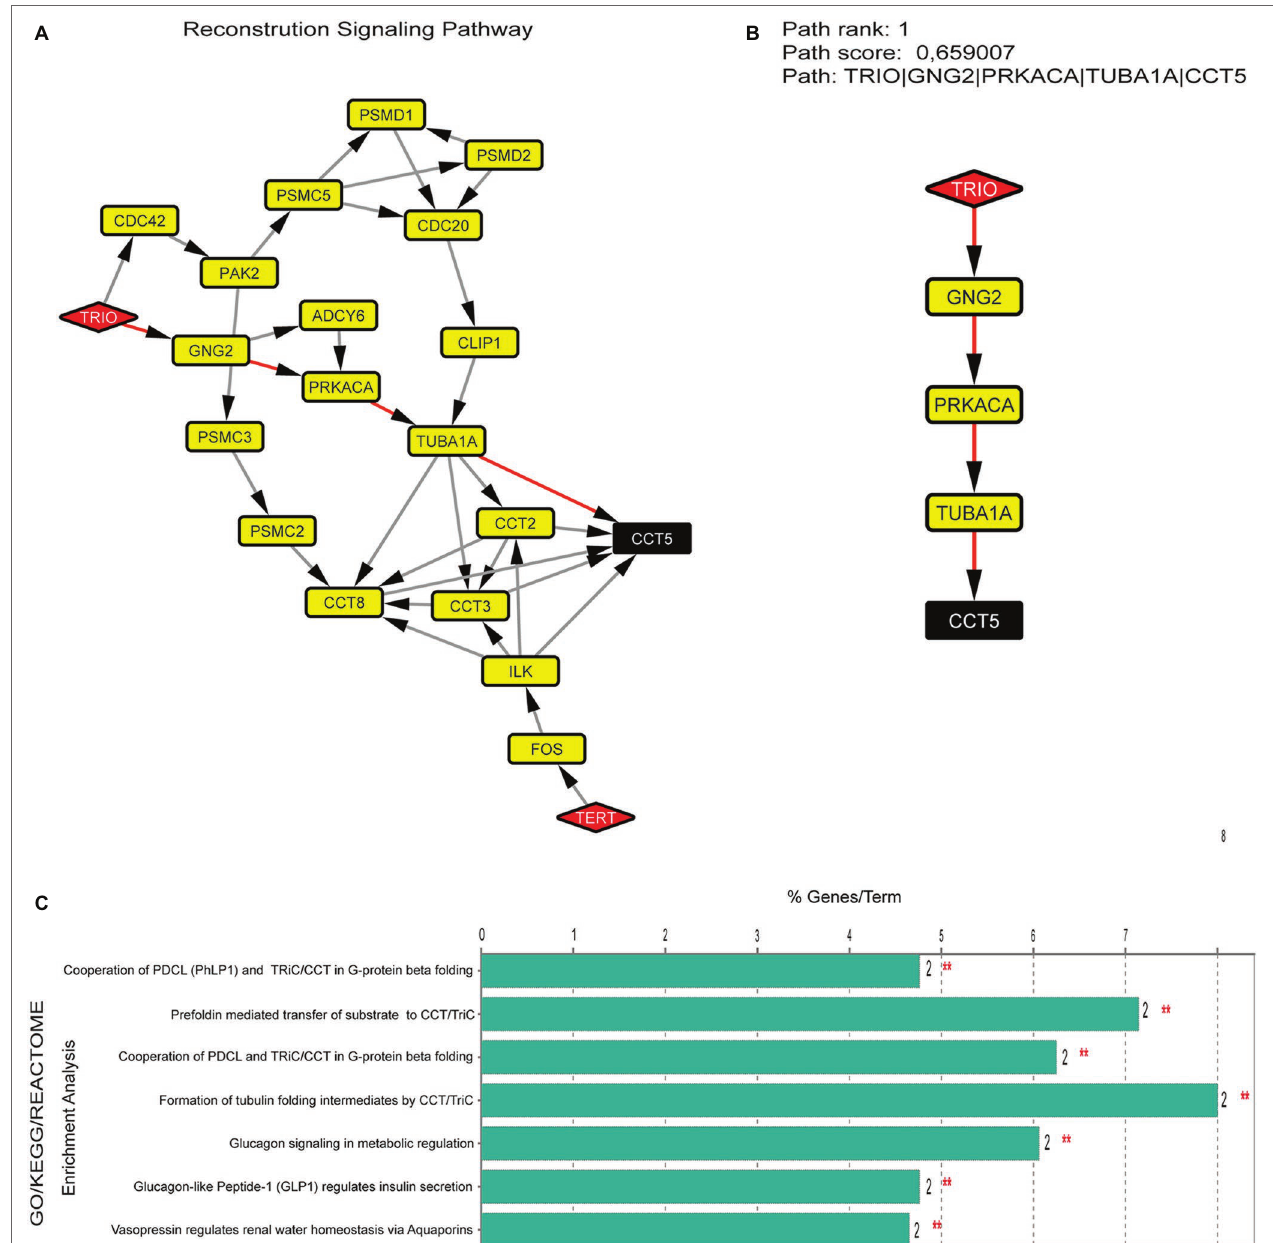
FIGURE 3 | (A) Signaling pathway identified between H-B (TRIO, CCT5, and TERT), using the Pathlinker plugin. (B) Pathway better ranked by path score between 50 possible pathways. (C) Enrichment analysis in proteins present in the pathway (TRIO, GNG2, PRKACA, TUBA1A, and